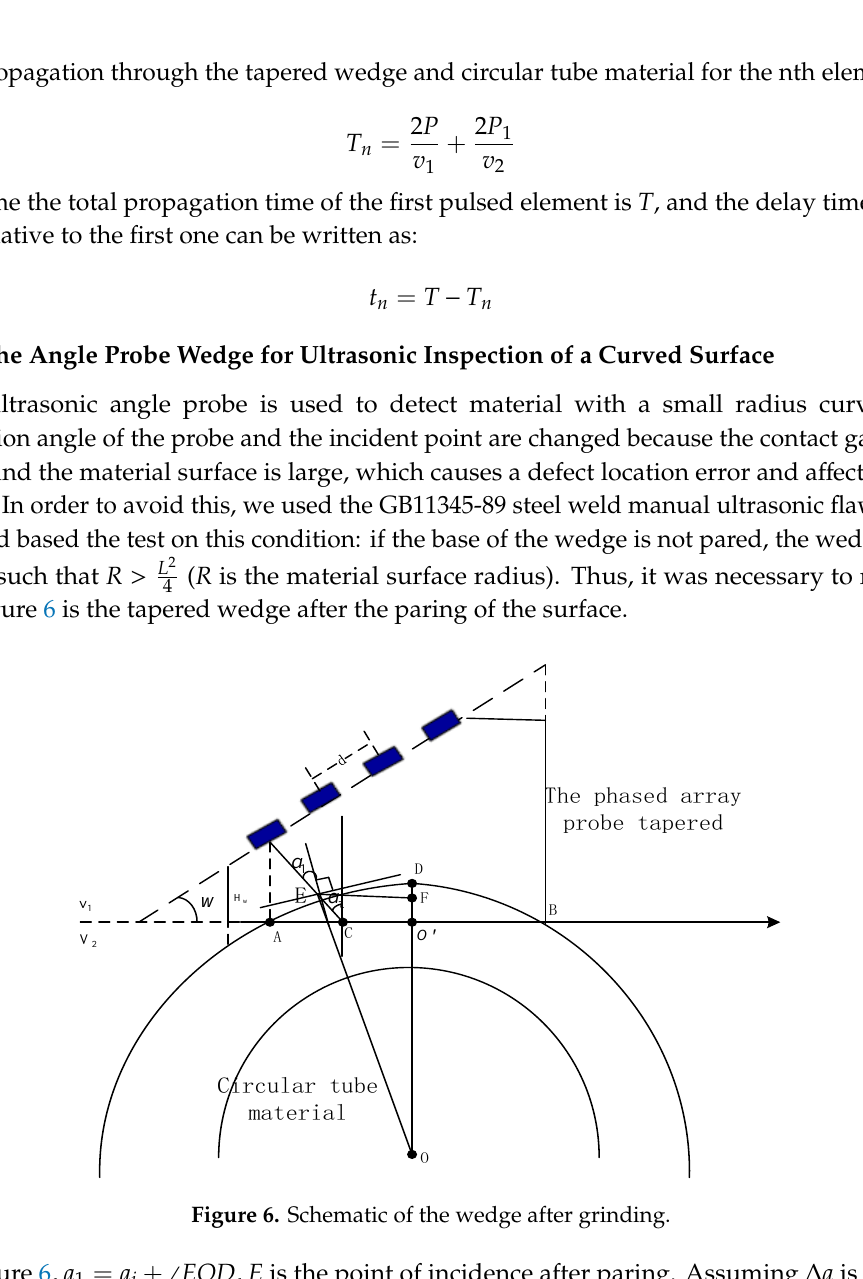
Figure 5. Focusing beam from the linear phased-array transducer in the tapered wedge.